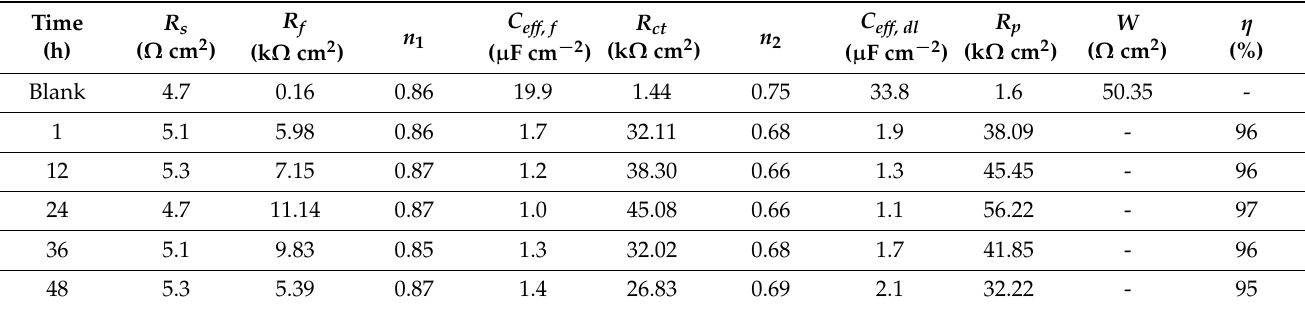
Table 2. EIS parameters for copper in 3.5 wt.% NaCl solution and in the presence of ATZD at 298 K and different immersion times.